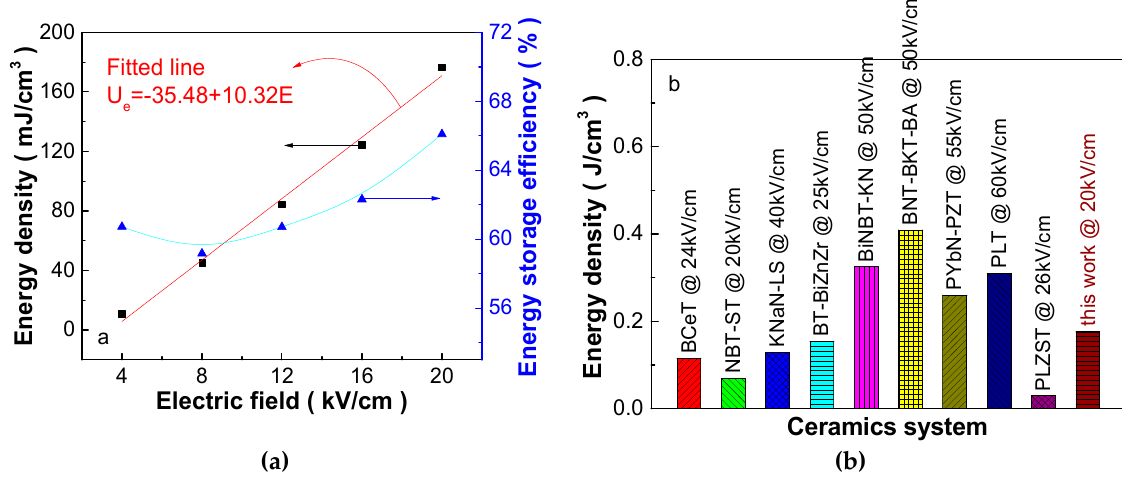
Figure 3. ( a ) Variation of energy-storage density and energy-storage efficiency as a function of electric field of the 0.25 mol% Y 2 O 3 -doped PSLZSnT ceramics; ( b ) comparison of energy-storage performance of some recently reported ferroelectric and antiferroelectric ceramics, in which BCeT is BaCe 0.15 Ti 0.85 O 3 [20]; NBT-ST is 0.7(Na 0.5 Bi 0.5 )TiO 3 -0.3SrTiO 3 [21]; KNaN-LS is 0.97(K 0.5 Na 0.5 )NbO 3 -0.03LiSbO 3 [22]; BT-BiZnZr is 0.9BaTiO 3 -0.1Bi(Zn 0.5 Zr 0.5 )O 3 [23]; BiNBT-KN is 0.94Bi 0.47 Na 0.47 Ba 0.06 TiO 3 -0.06KNbO 3 [24]; BNT-BKT-BA is 0.94(0.75Bi 0.5 Na 0.5 TiO 3 -0.25Bi 0.5 K 0.5 TiO 3 )-0.06BiAlO 3 [25]; PYbN-PZT is 0.075Pb(Yb 1/2 Nb 1/2 )O 3 -0.925Pb(Zr 0.36 Ti 0.64 )O 3 [17]; PLT is (Pb 1-x La x )Ti 1-x/4 O 3 (x = 0.28) [26]; and PLZST is Pb 0.94 La 0.04 [(Zr 0.7 Sn 0.3 ) 0.9 Ti 0.1 ]O 3 [19].